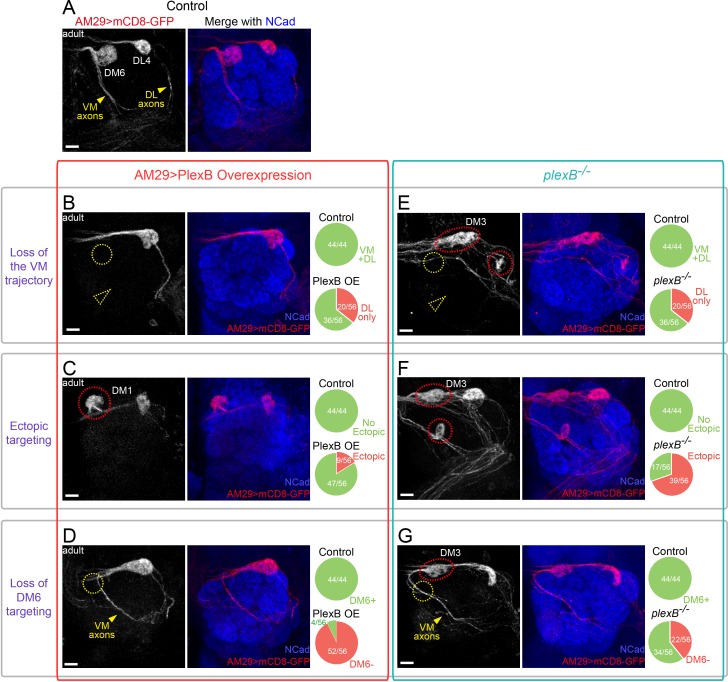
Glomerular selection of AM29+ ORNs requires specific levels of PlexB.(A) ORN axons innervating the DL4 and DM6 glomeruli were labeled by membrane-tethered GFP driven by AM29-GAL4. DL4 and DM6 ORN axons choose the DL and VM trajectories, respectively (yellow arrowheads). (B) Overexpression of PlexB by AM29-GAL4 causes the loss of the VM trajectory (dotted yellow arrowhead) and the loss of DM6 glomerular targeting (dotted yellow circle). (C) PlexB overexpression causes ectopic targeting to dorsal glomeruli (dotted red circle), mainly DM1 (56% of mis-targeting cases). (D) In more than half of the antennal lobes in the PlexB overexpression flies, DM6 glomerular targeting disappears (dotted yellow circle) although VM axons still exist and pass by the vicinity of the putative DM6 area (yellow arrowhead). (E) VM axons disappear (dotted yellow arrowhead) in about 1/3 of plexB mutant brains. Loss of DM6 glomerular targeting (dotted yellow circle), as well as ectopic glomerular targeting (dotted red circles), was also observed in this example antennal lobe. (F) In plexB mutants, AM29+ ORN axons ectopically target to DM3 and other glomeruli (dotted red circles; DM3: 51% of mis-targeting cases) but not DM1. (G) plexB mutants lose DM6 glomerular innervation (dotted yellow circle), even when VM axons are present and pass by the vicinity of DM6 (yellow arrowhead). Ectopic targeting to DM3 is also observed in the shown antennal lobe (dotted red circle). Antennal lobe counts of each phenotype and sample sizes are noted in the pie charts. Images are shown as maximum z-projections of confocal stacks. Scale bars, 10 μm. Axes, D (dorsal), L (lateral).